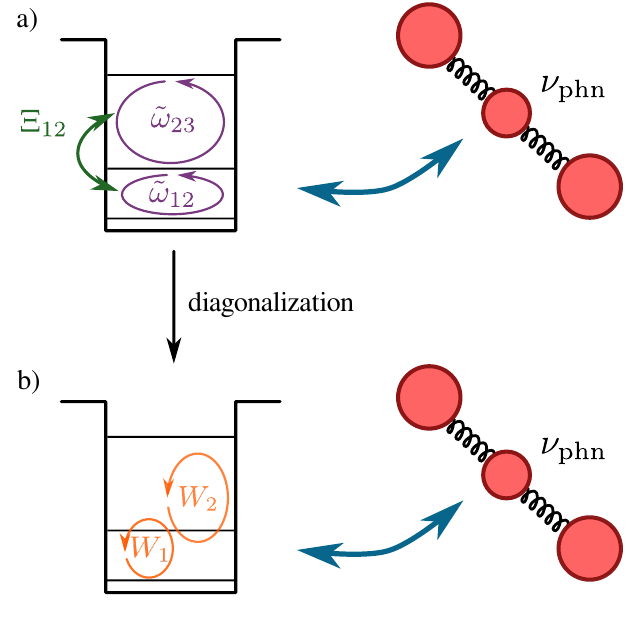
Figure 1. (Color online) ( a ) Scheme of the intersubband plasmons (purple arrows) and the interactions between them (green arrow) and their interaction with phonons (blue arrow). ( b ) Scheme of the multisubband plasmons of the system after diagonalization of intersubband interactions (orange arrows) and their interaction with phonons (blue